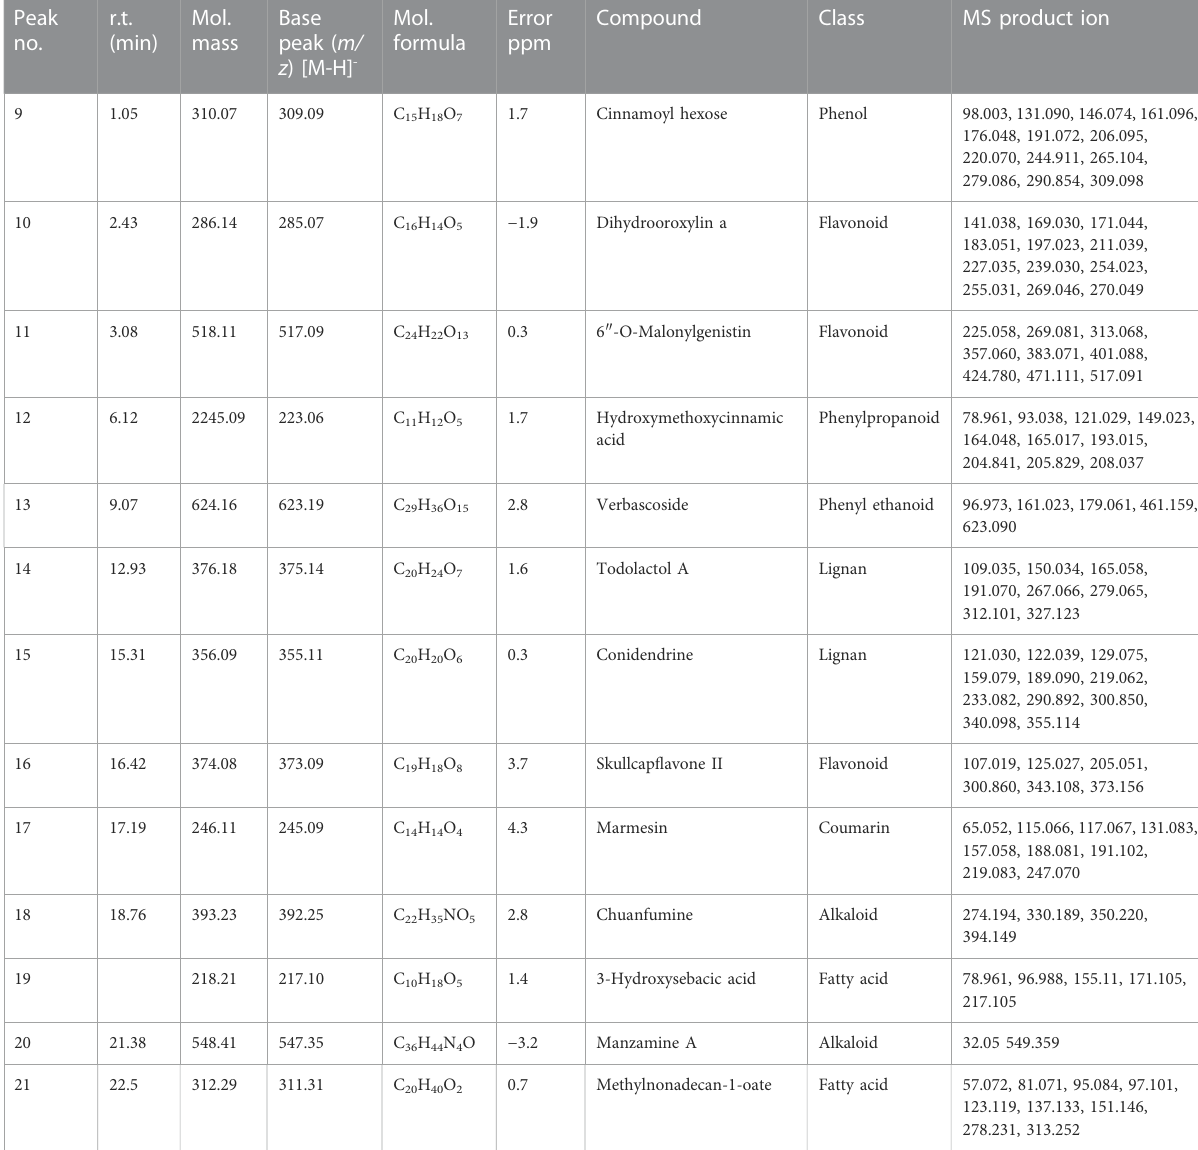
TABLE 2 Tentatively identi fi ed compounds in UPLC-Q-TOF-MS (negative mode) analysis of HAECA. Peak